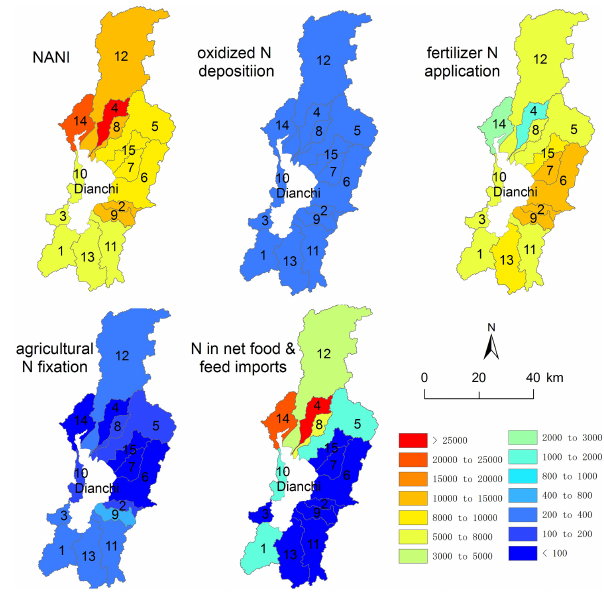
Figure 2. NANI (kgNkm − 2 yr − 1 ) and its components for the Lake Dianchi basin based on the area-weighting method. Overall, NANI in north Dianchi is larger than the south, and fertilizer is the biggest nitrogen input for most catchments.